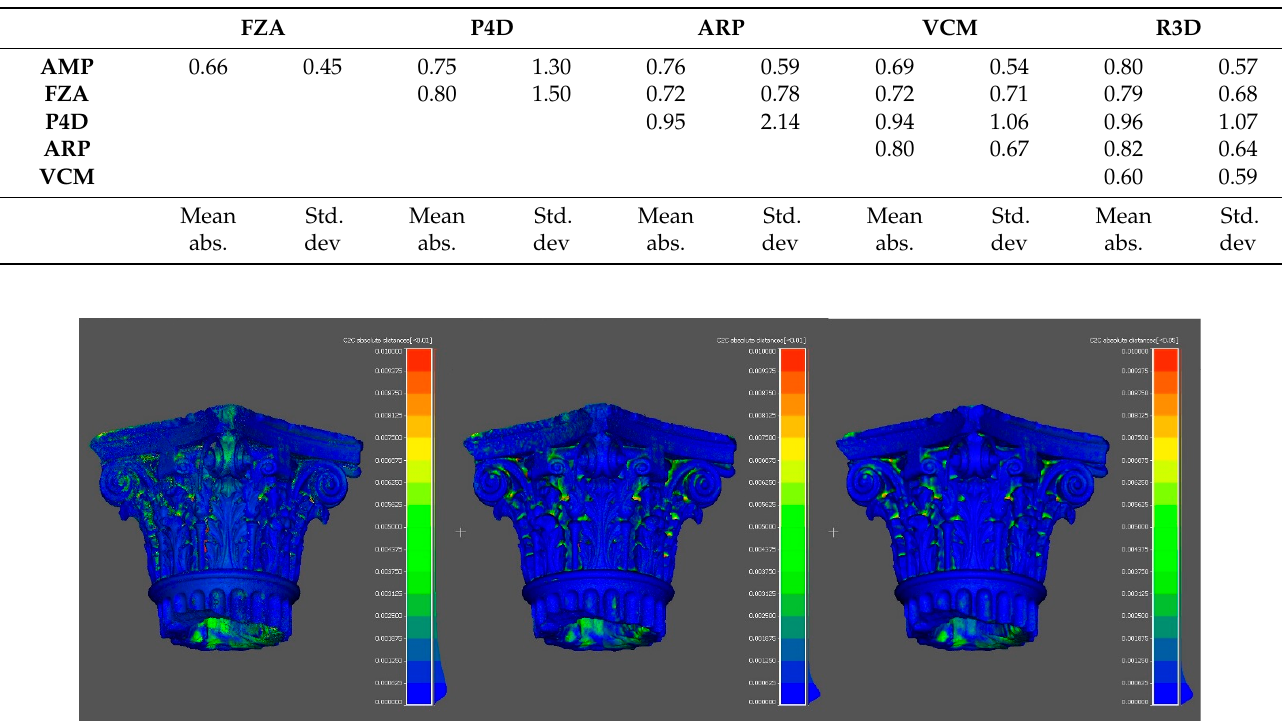
Table 11. Hausdorff distances between the photogrammetric models for the capital replica case study—dataset 4 (distances